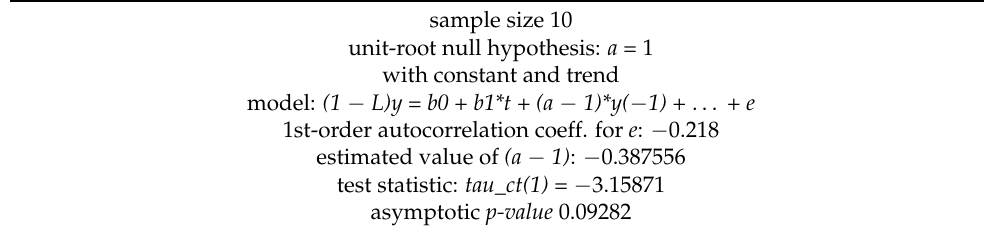
Table 4. Statistical properties of variables (ADF test) for D t including one lag of (1 − L) D t